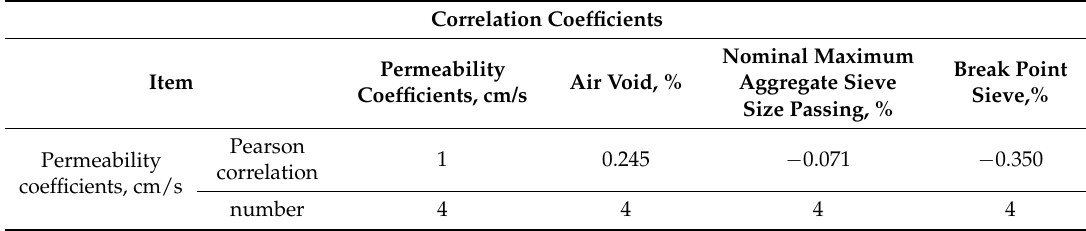
Table 9. Pearson correlation check of SMA mixes.